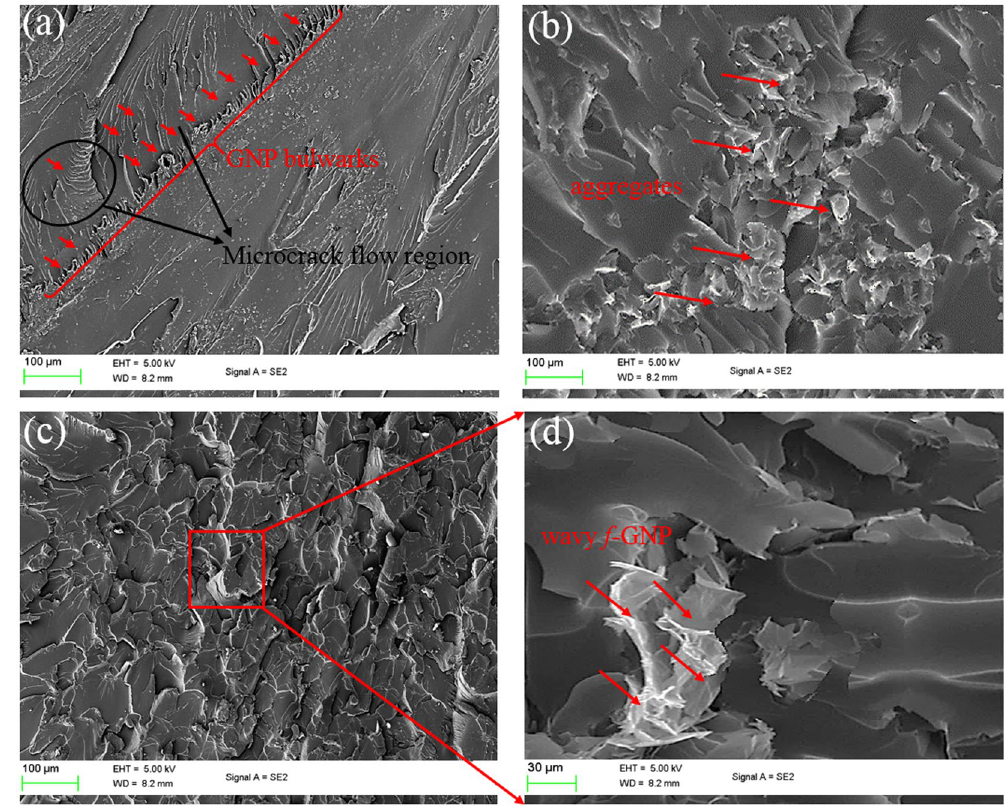
Figure 7. SEM images of fracture surfaces of epoxy/0.5% GNP ( a , b ) and epoxy/0.5% f -GNP ( c , d ) nanocomposites at different